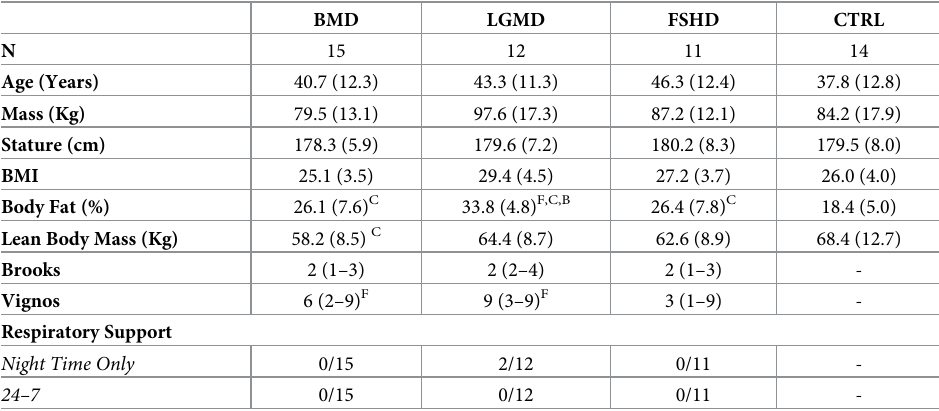
Table 1. Participant characteristics and body composition.